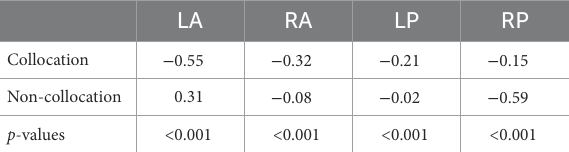
TABLE 2 Mean amplitudes for collocations and non-collocations in the left/right anterior, posterior areas.